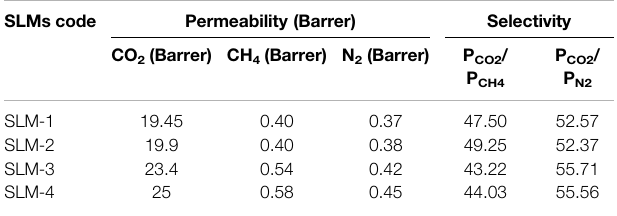
TABLE 4 | CO 2 /CH 4 and CO 2 /N 2 mixed gas permeability and